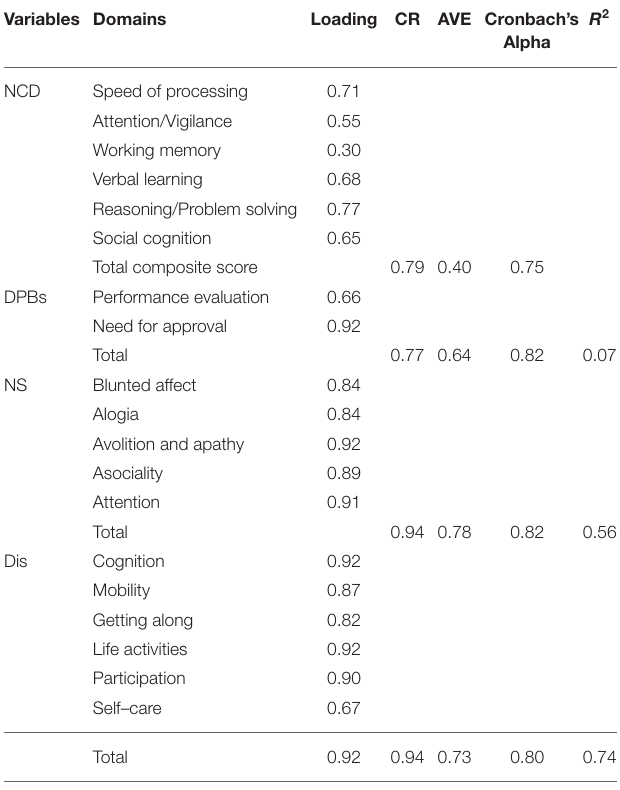
TABLE 3 | Assessment of measurement model of latent Variables ( n = 85).